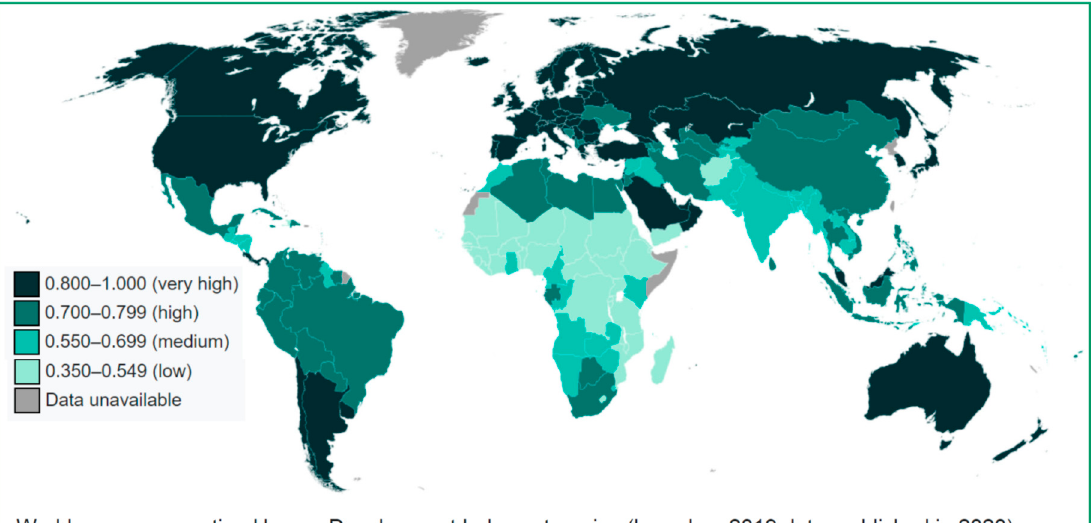
Figure 2. Geographical distribution of an Inequality-adjusted Human Development Index IHDI for individual countries.